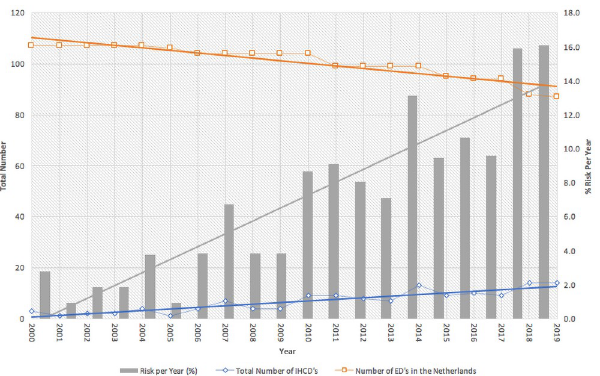
Fig 2. Number of emergency departments plotted against the total number of internal hospital crisis and disasters. The calculated risk (in %) is depicted per year, showing an increasing trend.